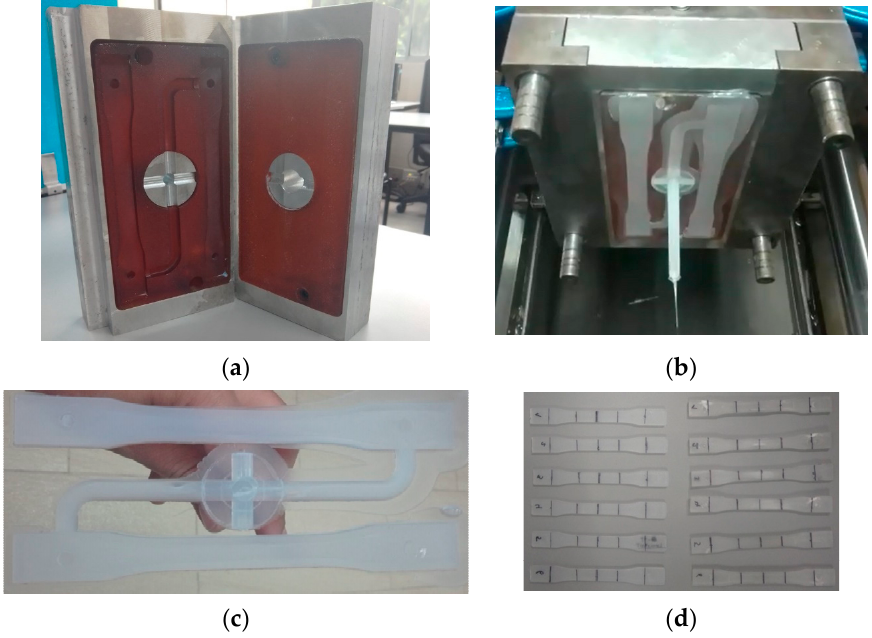
Figure 5. ( a ) Resin mold inserts obtained by additive manufacturing in a Photocentric LC Magna 3D printer. ( b ) Polypropylene specimens injected into the mold with inserts produced by additive manufacturing. ( c ) Polypropylene specimens and feeding system obtained (100% filling). ( d ) Functional polypropylene specimens for ASTM D638 tensile testing.